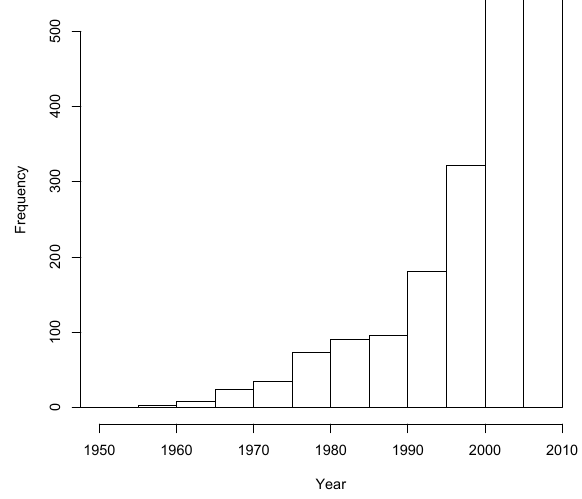
Fig. 1. Soil respiration studies over time, from the ISI Web of Sci- ence™